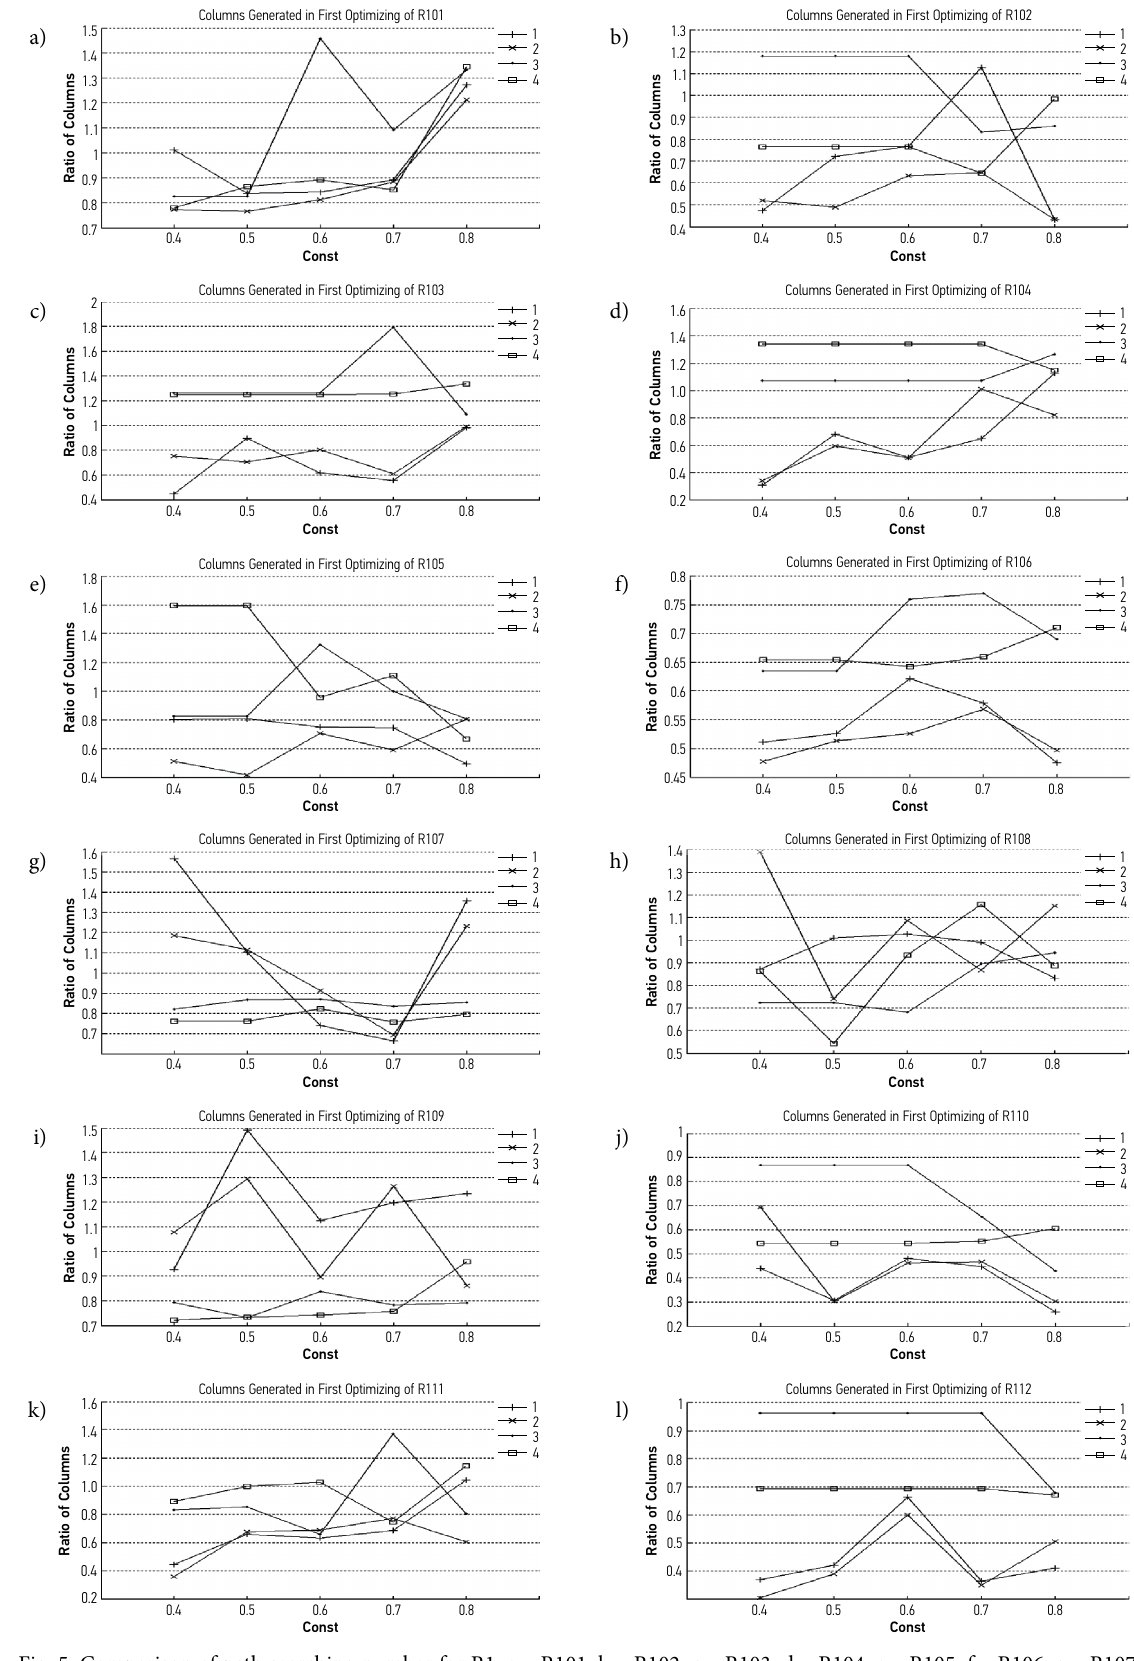
Fig. 5. Comparison of path searching number for R1: a – R101; b – R102; c – R103; d – R104; e – R105; f – R106; g – R107; h – R108; i – R109; j – R110; k – R111; l –